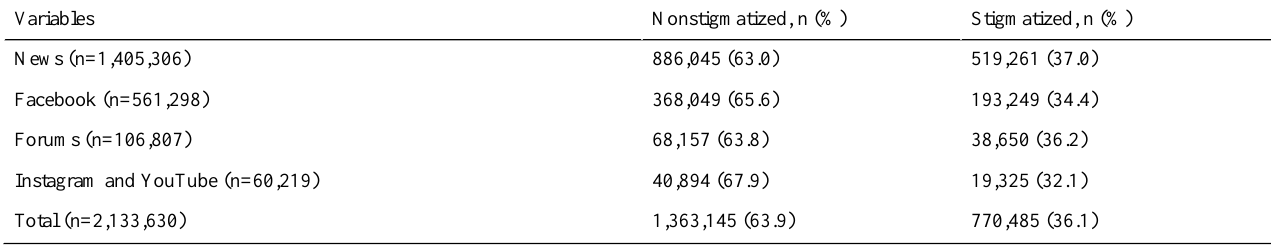
Table 2. Comparison of nonstigma (recommended) keywords and stigmatizing terms by media